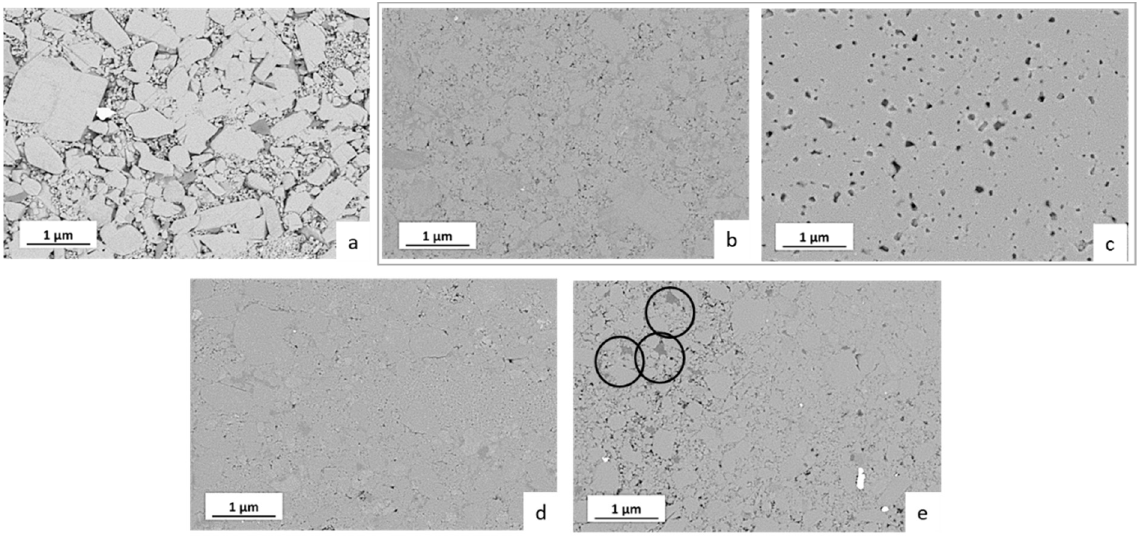
Figure 7. Microstructure (backscattered electrons mode) of the LATP ceramics cold-sintered at different conditions in relation to their density and ionic conductivity: ( a ) no additives, 140 °C (relative density 73%, total ionic conductivity 3.18 × 10 − 7 S/cm); ( b ) H 2 O, 200 °C (94%, 1.26 × 10 − 5 S/cm); ( c ) cold sintering using the same parameters as in ( b ) followed by post-annealing at 800 °C (95%, 1.55 × 10 − 4 S/cm); ( d ) HAc, 200 °C (94%, 0.82 × 10 − 5 S/cm); ( e ) LiAc, 200 °C (88%, 9.5 × 10 − 7 S/cm).